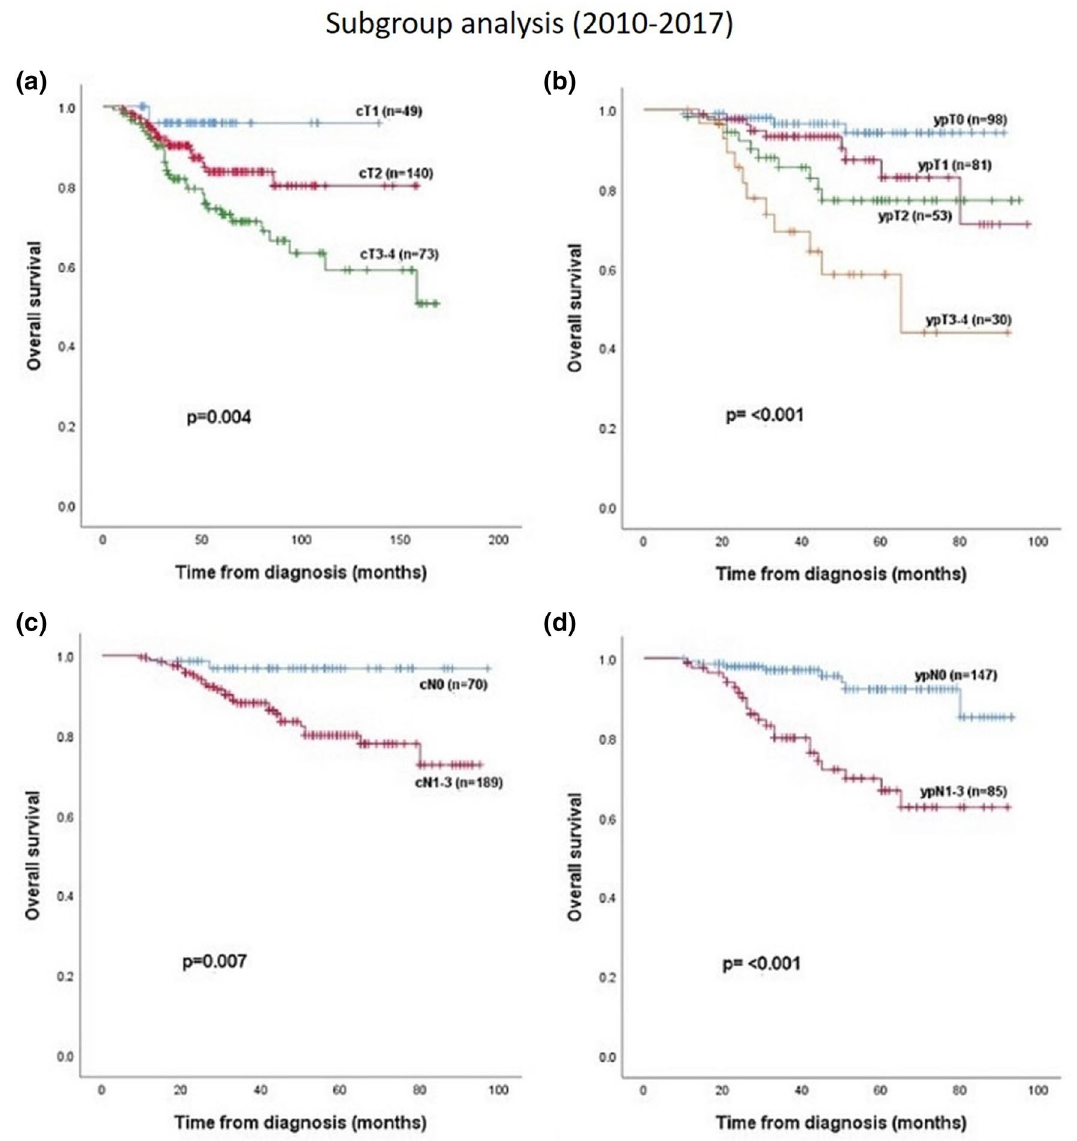
Figure 4. Overall survival in subgroup 2 (2010–2017) in relation to ( a ) cT-stadium, ( b ) ypT-stadium, ( c ) cN-stadium and ( d )